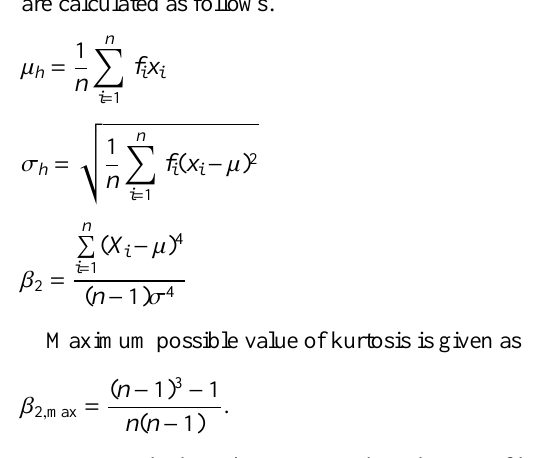
profiles are simulated and kurtosis is calculated by using his- togram.